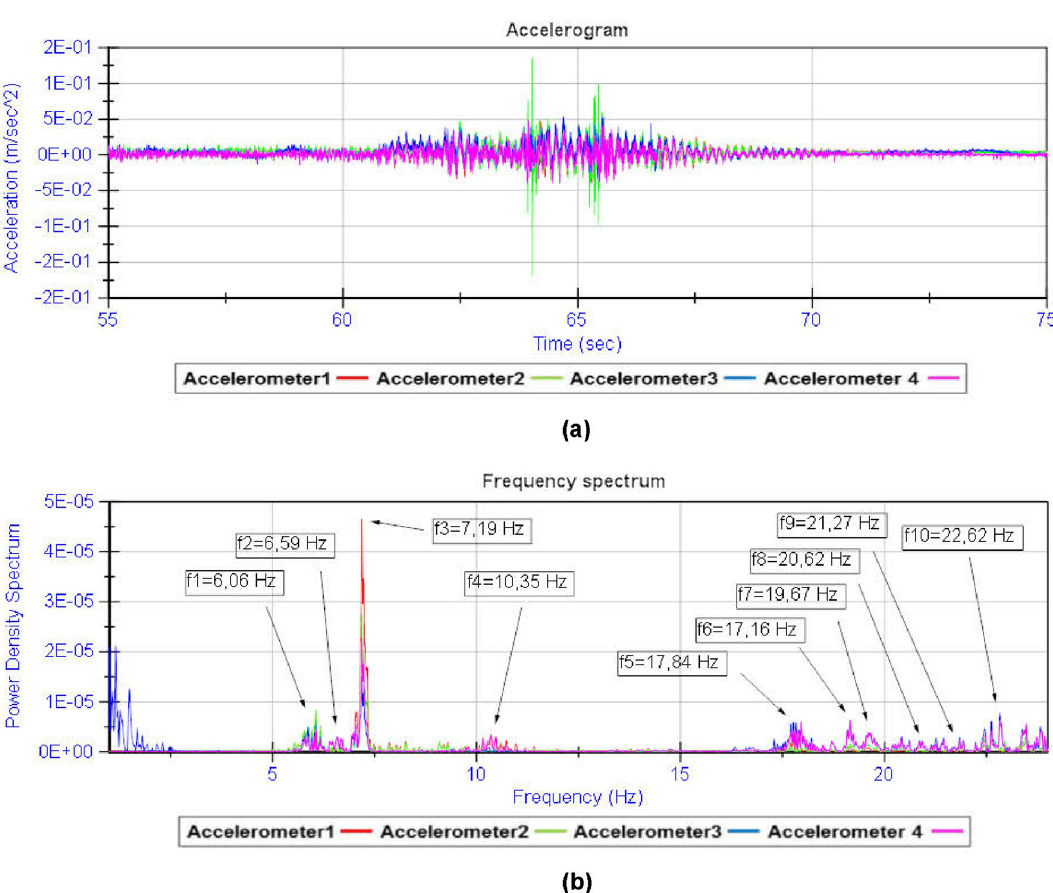
Figure 13. Analysis of the accelerations experienced by the girder bridge deck during the dynamic load test: ( a ) acceleration record; ( b ) frequency